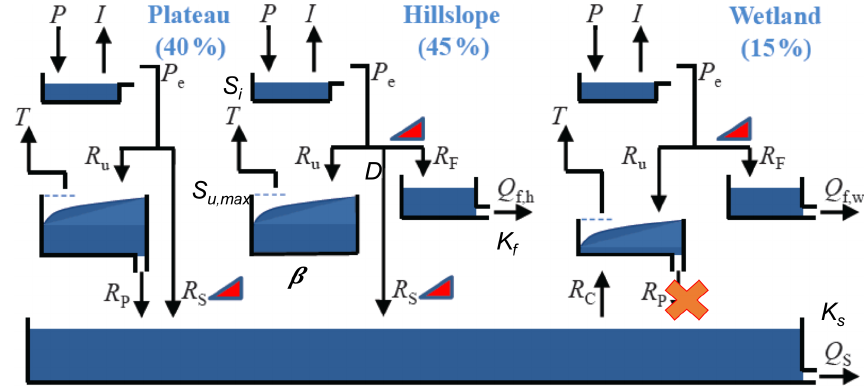
Figure 2. Example of a structure for a semi-distributed model consisting of three hydrologically distinct functional units based on the respective areal proportions of three landscape classes as derived from a digital elevation model, connected by a common groundwater system (after Gharari et al., 2014).